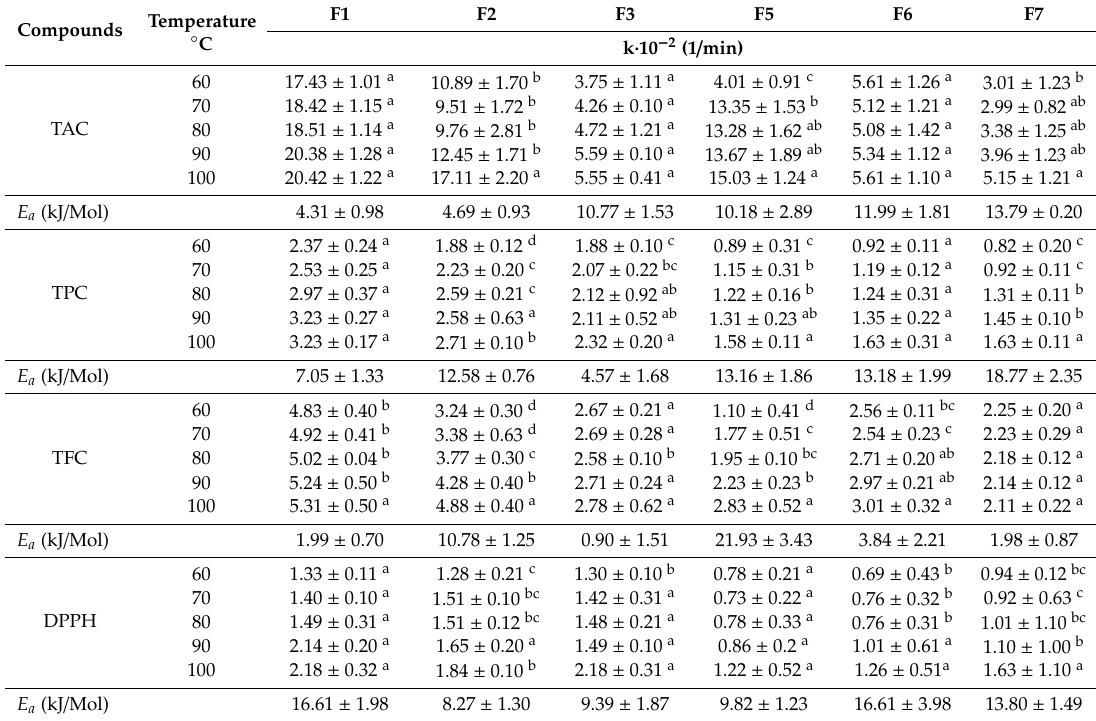
Table 1. Estimated kinetic parameters (rate constant— k and activation energy E a ) of phytochemicals thermal degradation in black rice sieving fractions